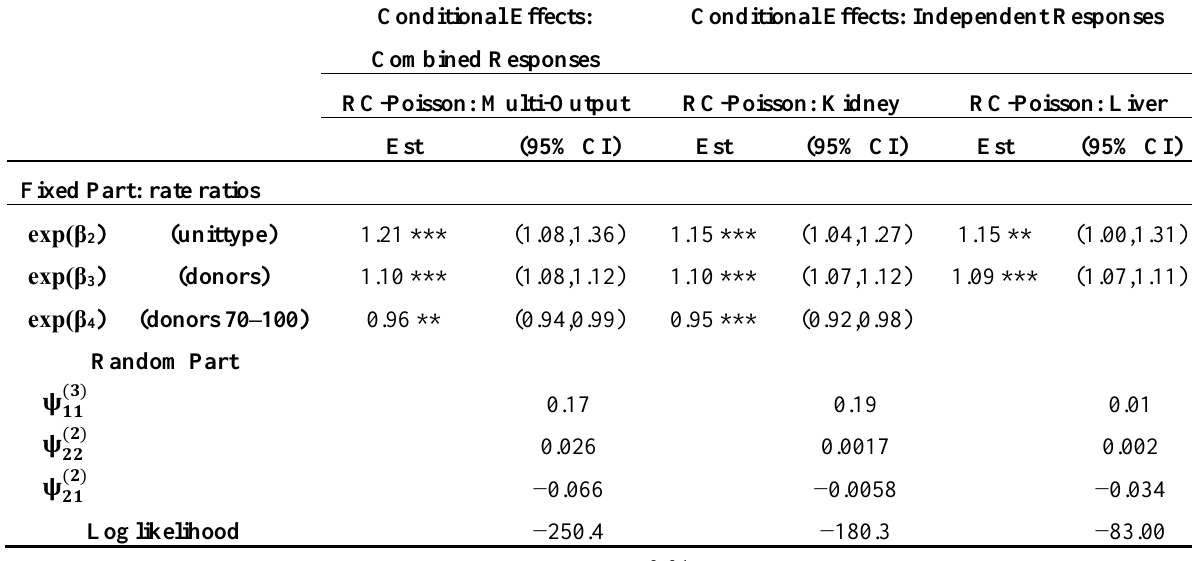
Table 2. Computed estimates for different technology